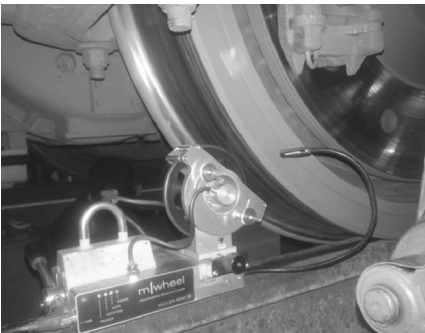
Figure 1: Wheel polygonalization measurements in field